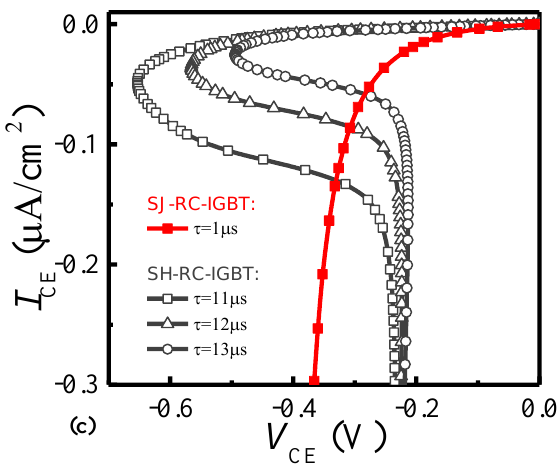
Figure 5. ( a ) Forward conduction of I CE versus V CE and ( b ) reverse conduction of I CE versus V CE . In CRC-IGBT, Lp (the length of P+ collector region) is changed at forward and reverse conduction. ( c ) Reverse snapback curves. FP-RC-IGBT is referenced from [8].